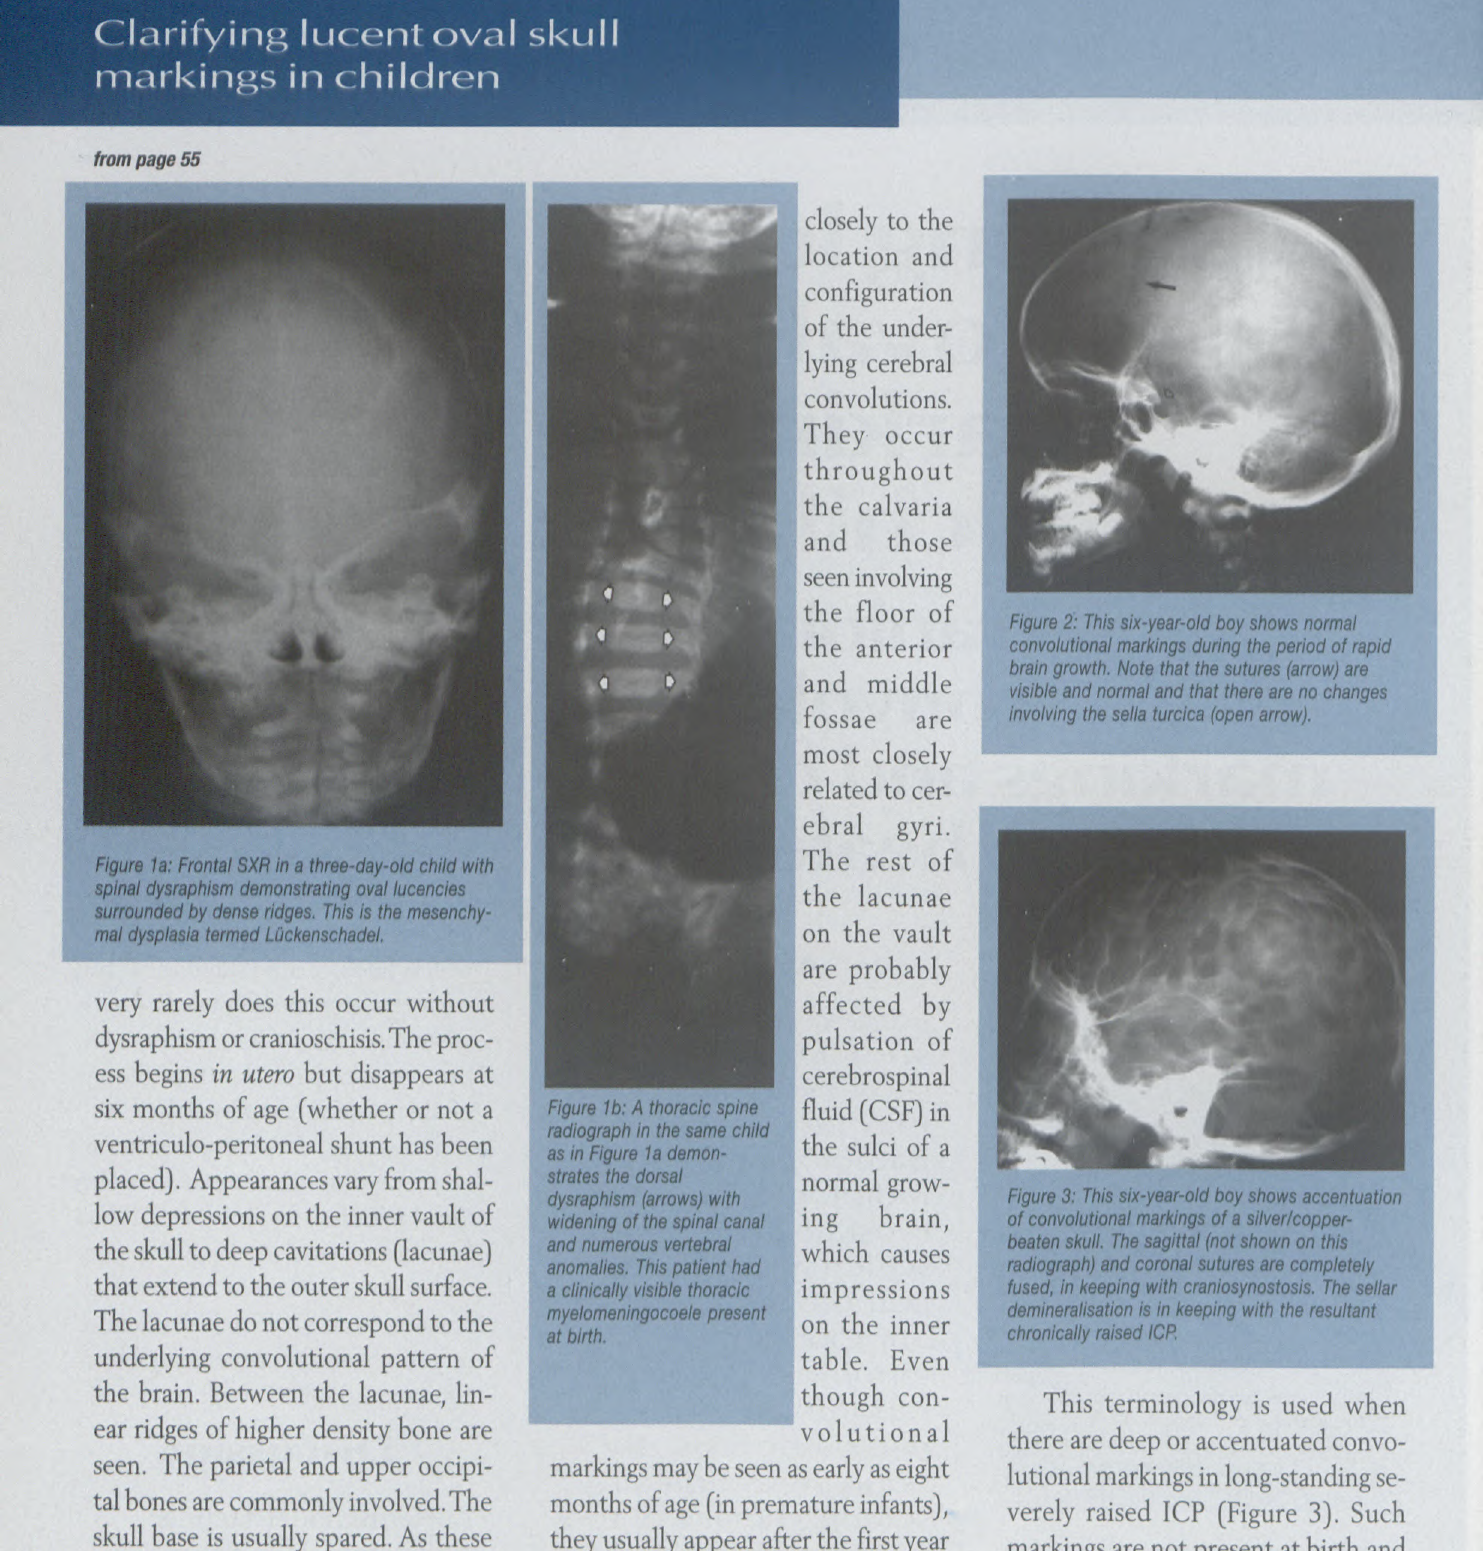
Figure 3: This six-year-old boy shows accentuation of convolutional markings of a silver/copper- beaten skull Thesagittal (not shown on this radiograph) and coronal sutures are completely fused, in keeping with craniosynostosis. The sellar demineralisation is in keeping with the resultant chronically raised